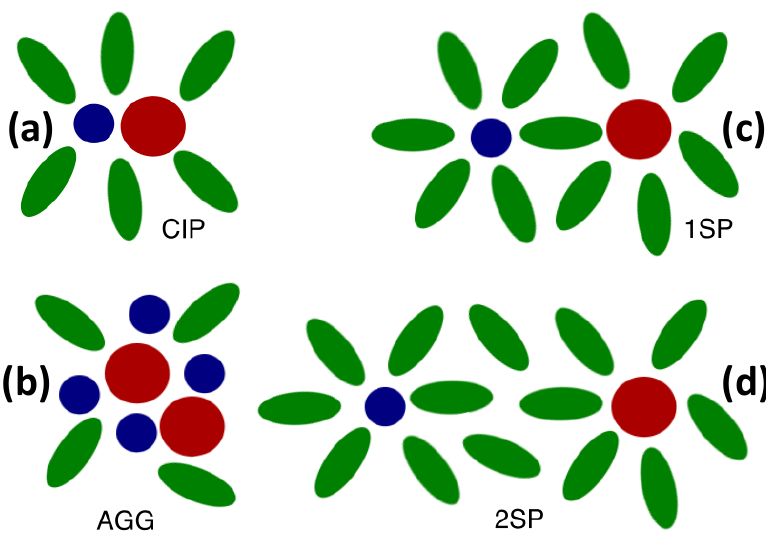
Figure 3. Schematic illustration of distinct ion complex states. ( a ) Direct contact pairs (CIP) and ( b ) ion aggregates (AGG) without solvation shells between the ions. ( c ) Solvent-shared (1SP) and ( d ) solvent-separated ion pairs (2SP) with one or more solvation shells between the associated ions. Anions and cations are depicted as red big or blue small spheres, respectively. Solvent molecules are illustrated as green